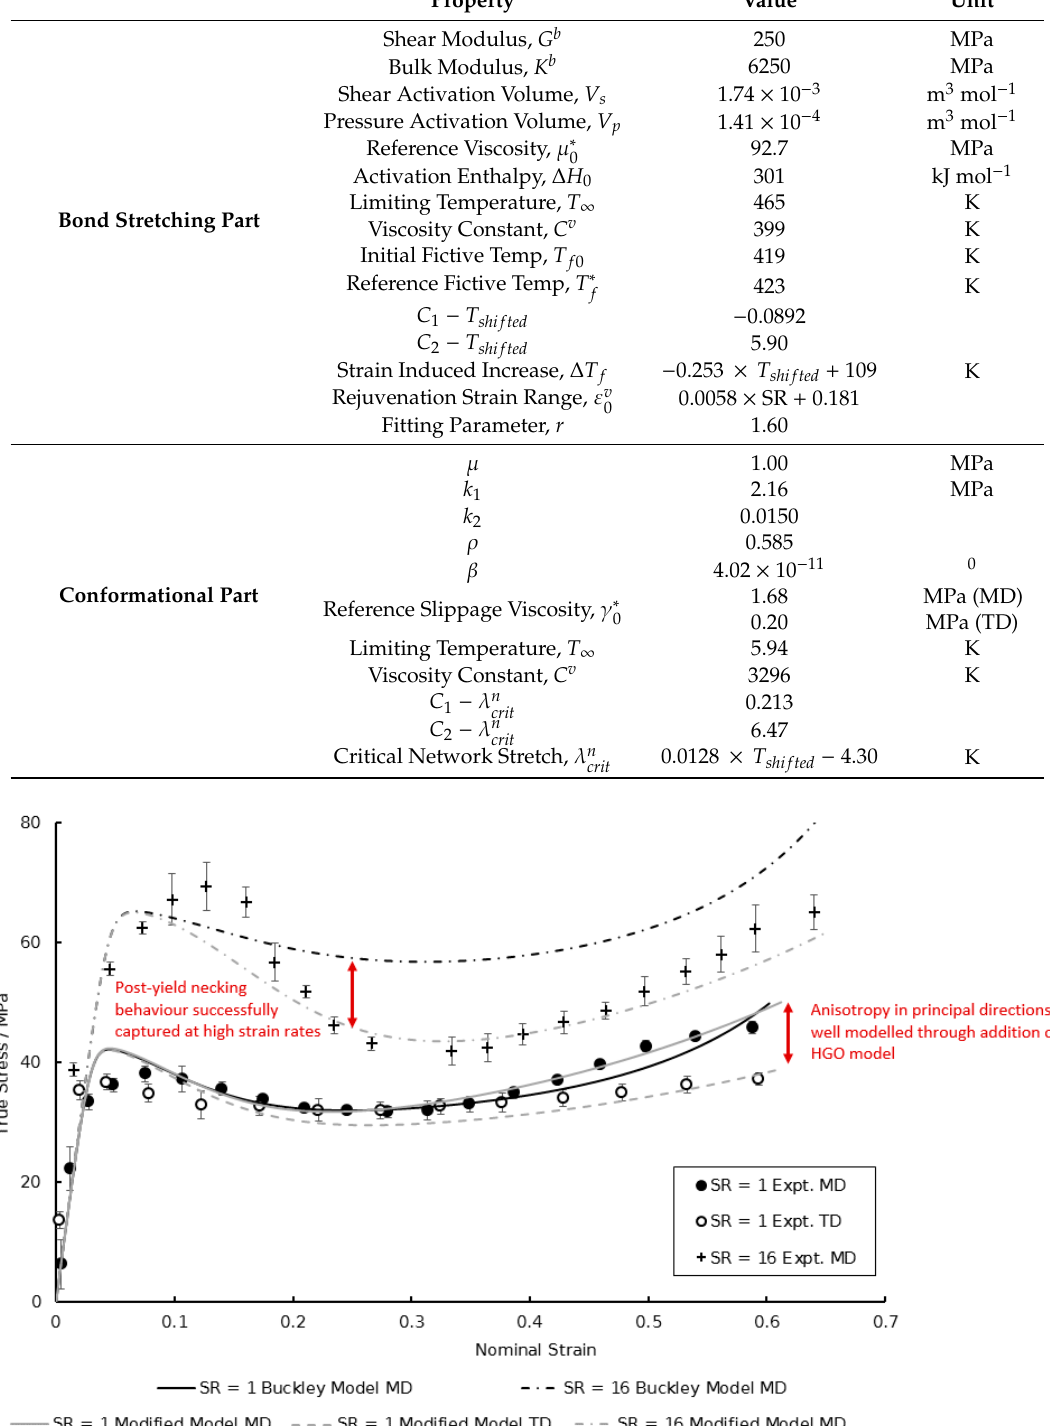
Figure 18. Comparison between simulated and experimental EB deformation behaviour of PEEK in machine and transverse directions at strain rates of 1 and 16 s -1 at a temperature of 130 °C. Table 4. Comparison in observed root mean squared errors (%RMSE) between predicted and observed stress–strain behaviour, for the modified and original Buckley material model, at a temperature of 130 °C.